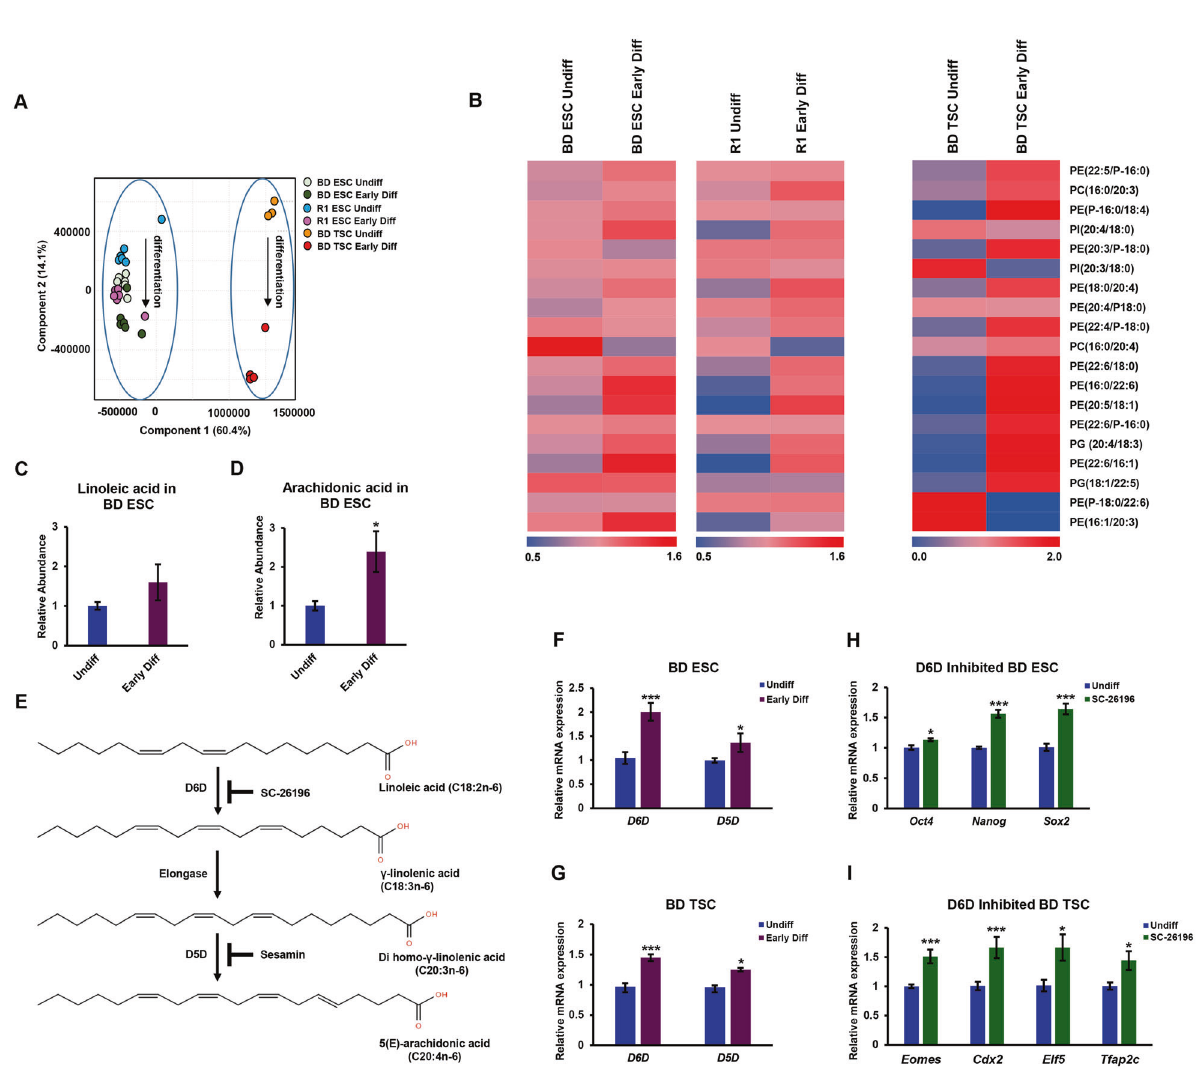
Fig. 2 Polyunsaturated lipids are a metabolic signature of early differentiating ESCs and TSCs. ESCs and TSCs of the same background (129/black 6) were seeded in Tx de fi ned culture medium. After 24 h, medium was changed to fresh medium with ( “ Undiff ” ) or without ( “ Early Diff ” ) factors that support self-renewal. Their metabolome was examined after 48 h, using 0.5 × 10 6 cells per sample. The second principal component (PC2) of a partial least squares discriminant analysis (PLS-DA; A ) shows discrete metabolome of the differentiating SCs. R 2 = 0.93, Q 2 = 0.83 ( n = 6). A heat map representation of the abundance of identi fi ed differential polyunsaturated phospholipids of the dataset shown in ( A ), following variable importance in projection (VIP; > 1) analysis ( B ). The abundance of each metabolic feature was normalized to the sum intensity of peaks of each chromatogram. The colors of quadrants in the heat maps represent the relative abundance of the metabolites, after normalization to the mean abundance of each metabolite across all samples ( n = 6). Following hydrolysis of lipids in ESC extracts, total abundance of linoleic acid ( C ) and arachidonic acid ( D ) was measured by GC-MS and normalized to the sum of peaks area. The biosynthesis of PUFAs starts from essential fatty acids with two double bonds, and is catalyzed by D6D and D5D ( E ). D6D and D5D expression is upregulated in early differentiating ESCs ( F ) and TSCs ( G ), as measured by RT-PCR ( n = 6). ESCs and TSCs (129/black 6 background) were treated by the D6D inhibitor SC-26196 (0.2 µM) or DMSO control for 48 h in feeder free culture without 2i/LIF or FGF4/TGF β /heparin, respectively, and the expression of stem cell markers was measured by RT-qPCR ( H, I ; n = 4). Values are the mean ± SEM. * P < 0.05; ** P < 0.01; *** P < 0.001. Cell Death and Disease (2022)